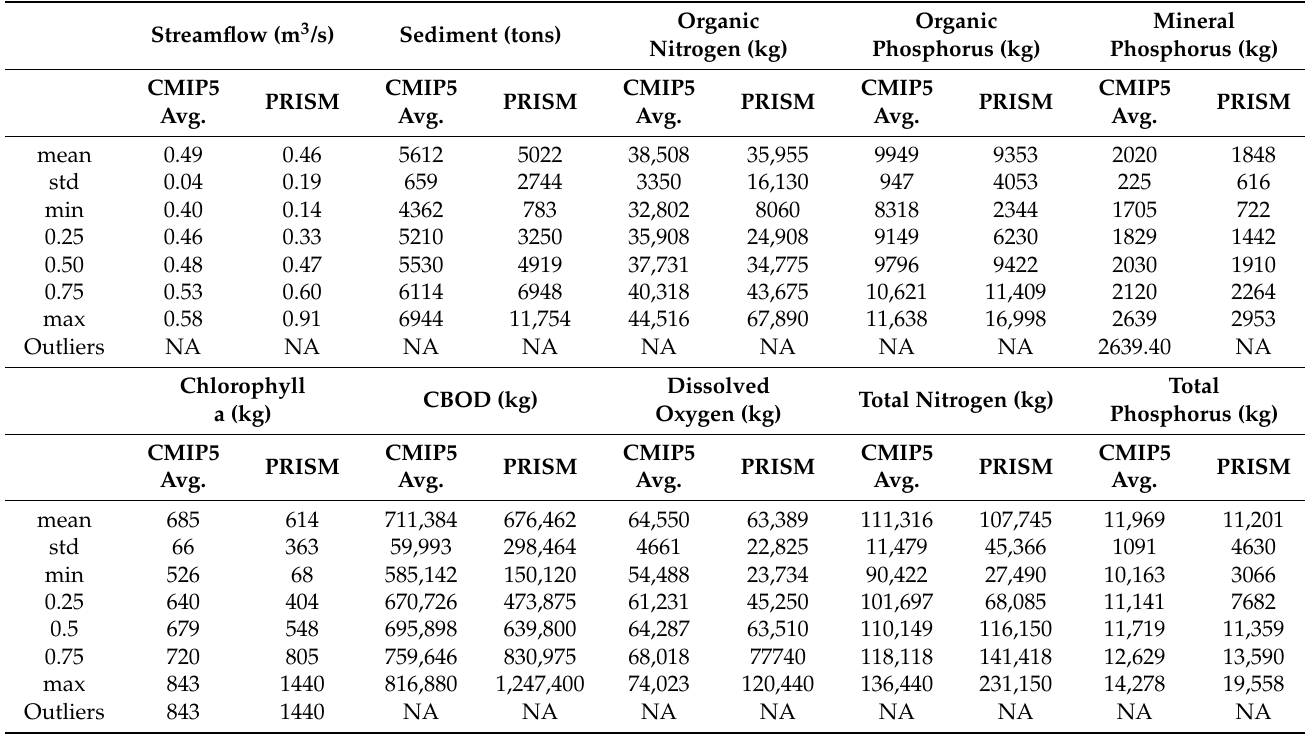
Table 4. Flow and WQ comparison between PRISM and average of 20 CMIP5 GCMs